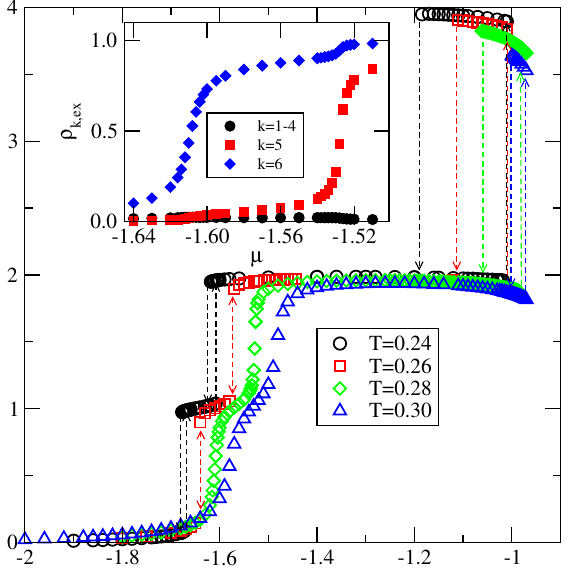
Figure 20. The excess adsorption isotherms for the system with V A = − 0.4 and V B = − 1.1. The inset shows the parts of excess isotherms of differently oriented particles at T = 0.28 in the region of µ over which the first two layers are formed.